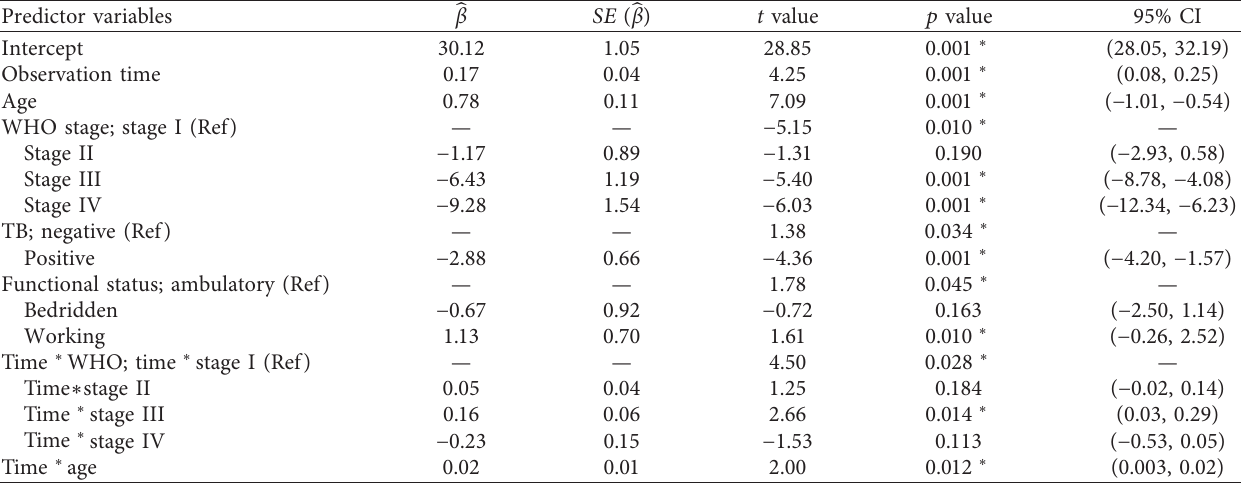
Table 3: Parameter estimate of the linear mixed-effect model with random intercept and randomslope. Predictor